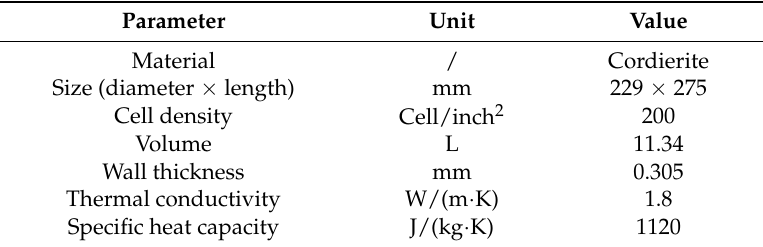
Table 2. Parameters of the diesel particulate filter (DPF).